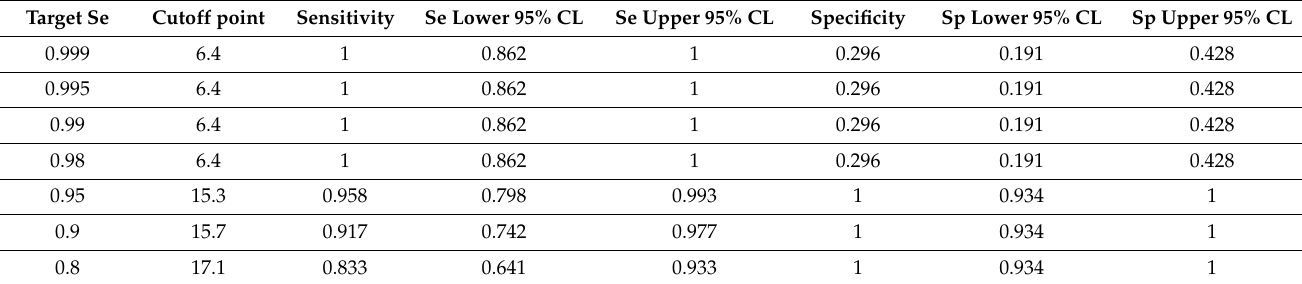
Table 6. Cutoff-point results for target sensitivity of a-MMP-8 level at T1.